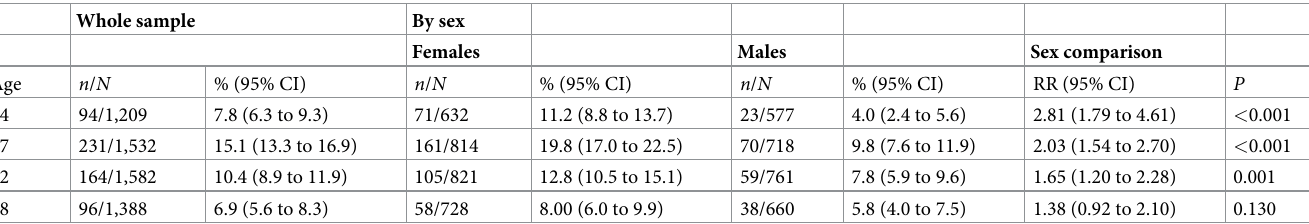
Females Males Sex comparison